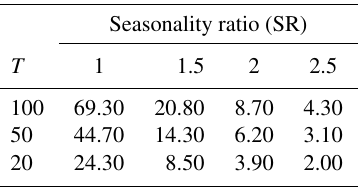
Table 4. Expected performance gain (%) from the regression model for various return periods.